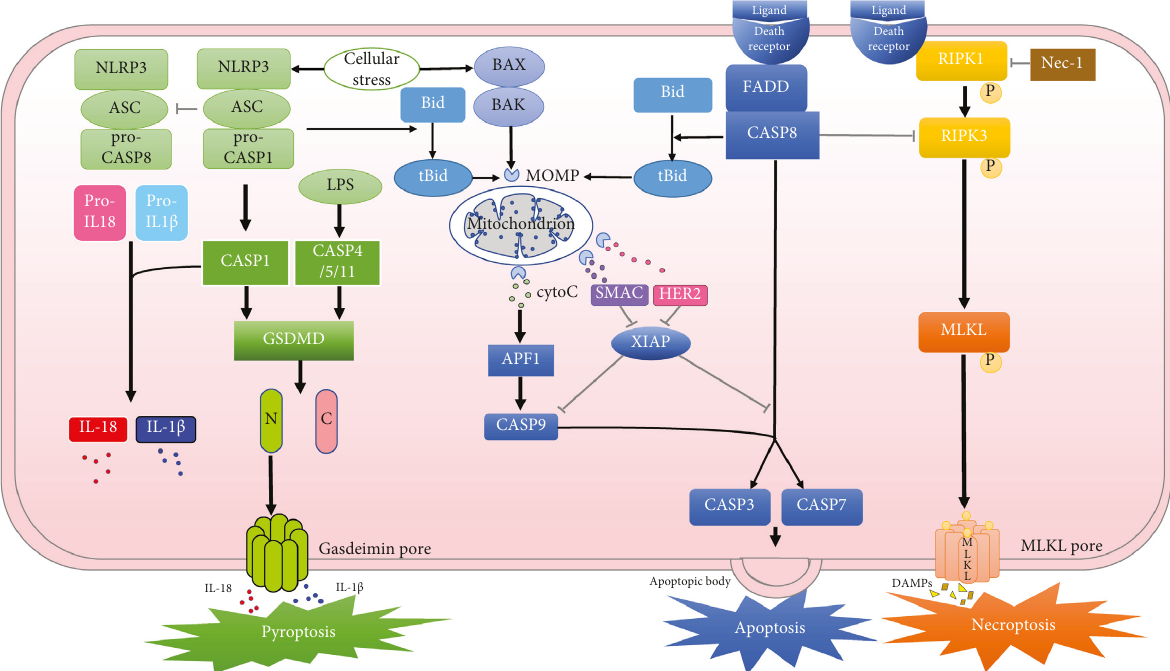
Figure 1: Molecular mechanisms of pyroptosis, apoptosis, and necroptosis and their network interactions. The intrinsic pathway of apoptosis (blue) is induced by the triggering of MOMP by BAX and BAK leading to cytochrome C activation and further activation of caspase-9 on APF1. Death receptor-mediated apoptosis requires the formation of a pro-apoptotic caspase-8 dimer, and both caspase-8 and caspase-9 promote the downstream executioner caspase-3 and caspase-7 activation, which induces apoptosis. Activation of death receptors similarly triggers necroptosis (orange). Activated RIPK3 phosphorylates and activates the executor of necroptosis, MLKL, which forms pores in the cell membrane, leading to cell lysis and the release of DAMPs. Cellular stress leads to inflammasome formation and activation of caspase-1 and cleavage of GSDMD, and cytokines such as IL-18 and IL-1 β are released through the membrane pores formed by GSDMD-N and trigger pyroptosis